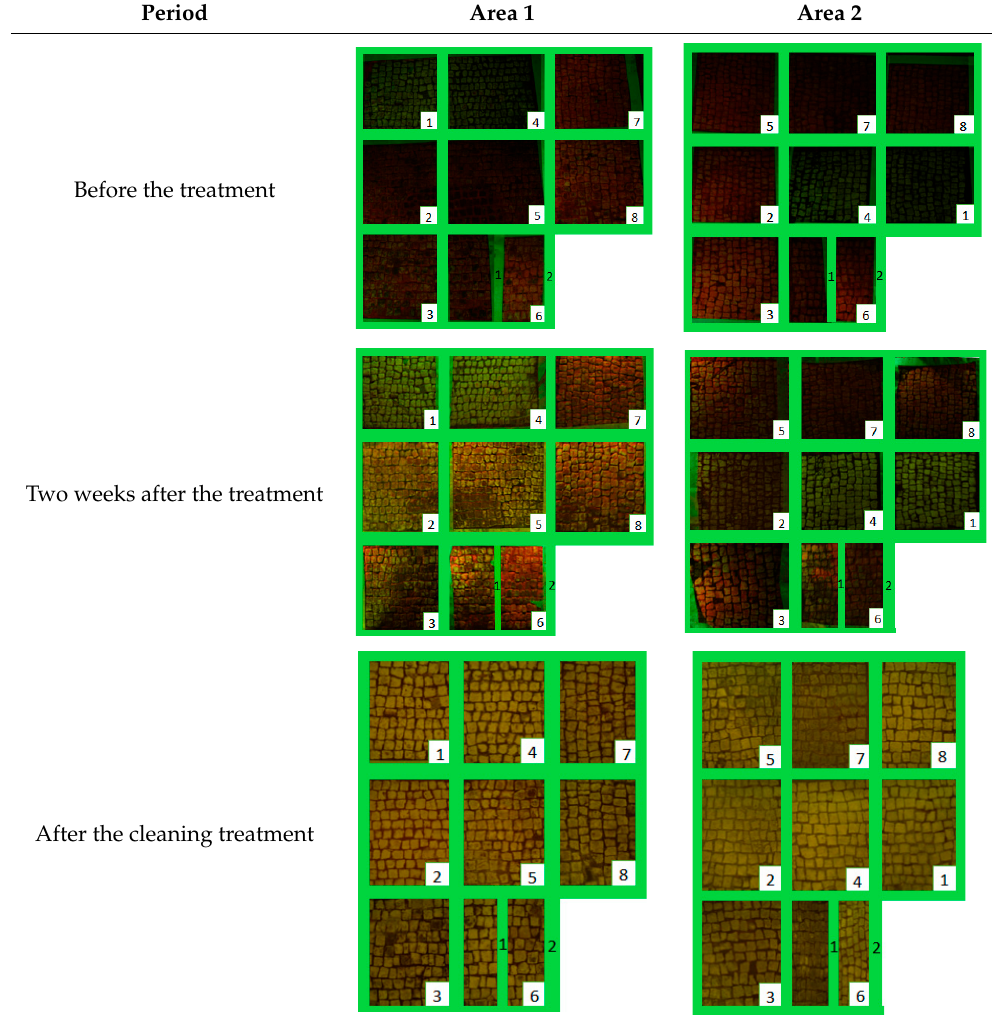
Table 6. The level of efficacy of each biocide treatment for Area 1 and Area 2. * indicates low effec- tiveness, ** medium efficacy, and *** strong action.